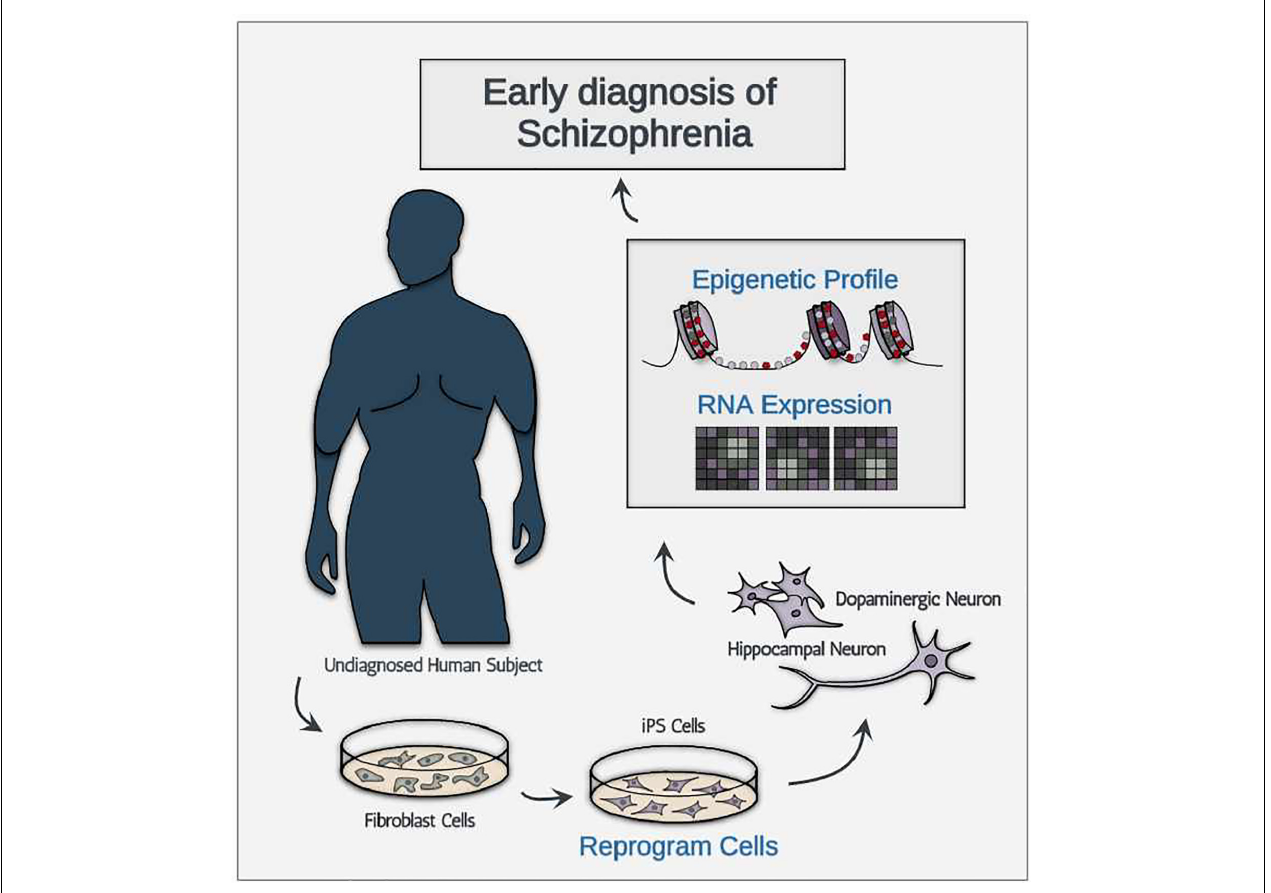
FIGURE 1 | A schematic illustration showing the conceptual diagnostic workflow consisting of iPSC-derived neurons for early diagnosis of schizophrenia.